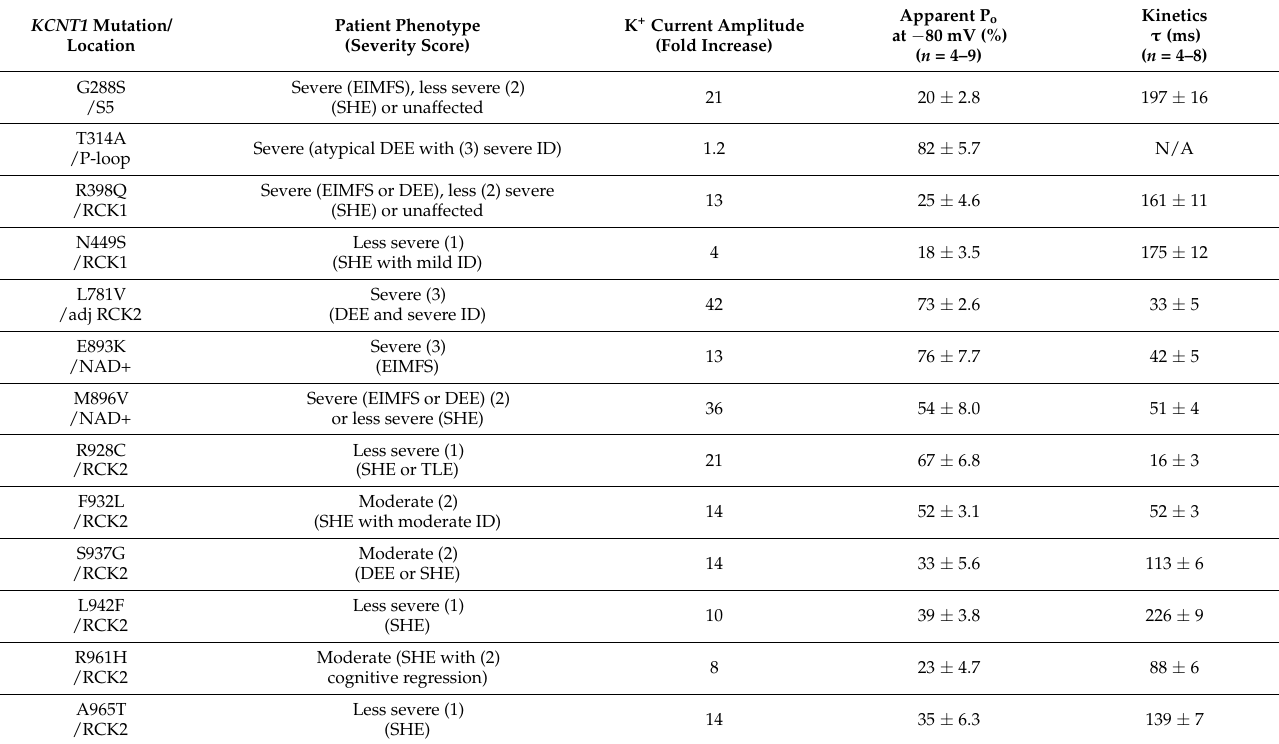
Abbreviations in the table: EIMFS—Epilepsy of Infancy with Migrating Focal Seizures; SHE—Sleep-Related Hypermotor Epilepsy; DEE—Developmental and Epileptic Encephalopathies; TLE—Temporal Lobe Epilepsy; ID—Intellectual